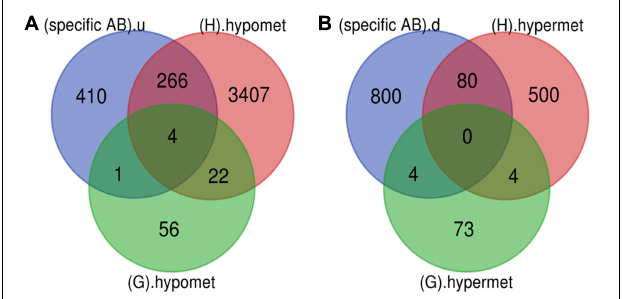
FIGURE 5 | Early genes. (A) Up-regulated and hypomethylated genes: total 83 genes were hypomethylated during NPDR while 3699 during PDR out of which 271 genes were also up-regulated in DR cases. 5 up-regulated and hypomethylated genes were present in NPDR stage of DR. (B) Down-regulated and hypermethylated genes: total 81 genes were hypermethylated during NPDR while 584 during PDR out of which 84 genes were also downregulated in DR cases. 4 down-regulated and hypermethylated genes were present in NPDR stage of DR (specific AB).u: (up-regulated genes specific for DR); (G).hypomet: (hypomethylated genes in NPDR); (H).hypomet: (hypomethylated genes in PDR); (specific AB).d: (down-regulated genes specific for DR); (G).hypermet: (hypermethylated genes in NPDR); (H).hypermet: (hypermethylated genes in PDR).